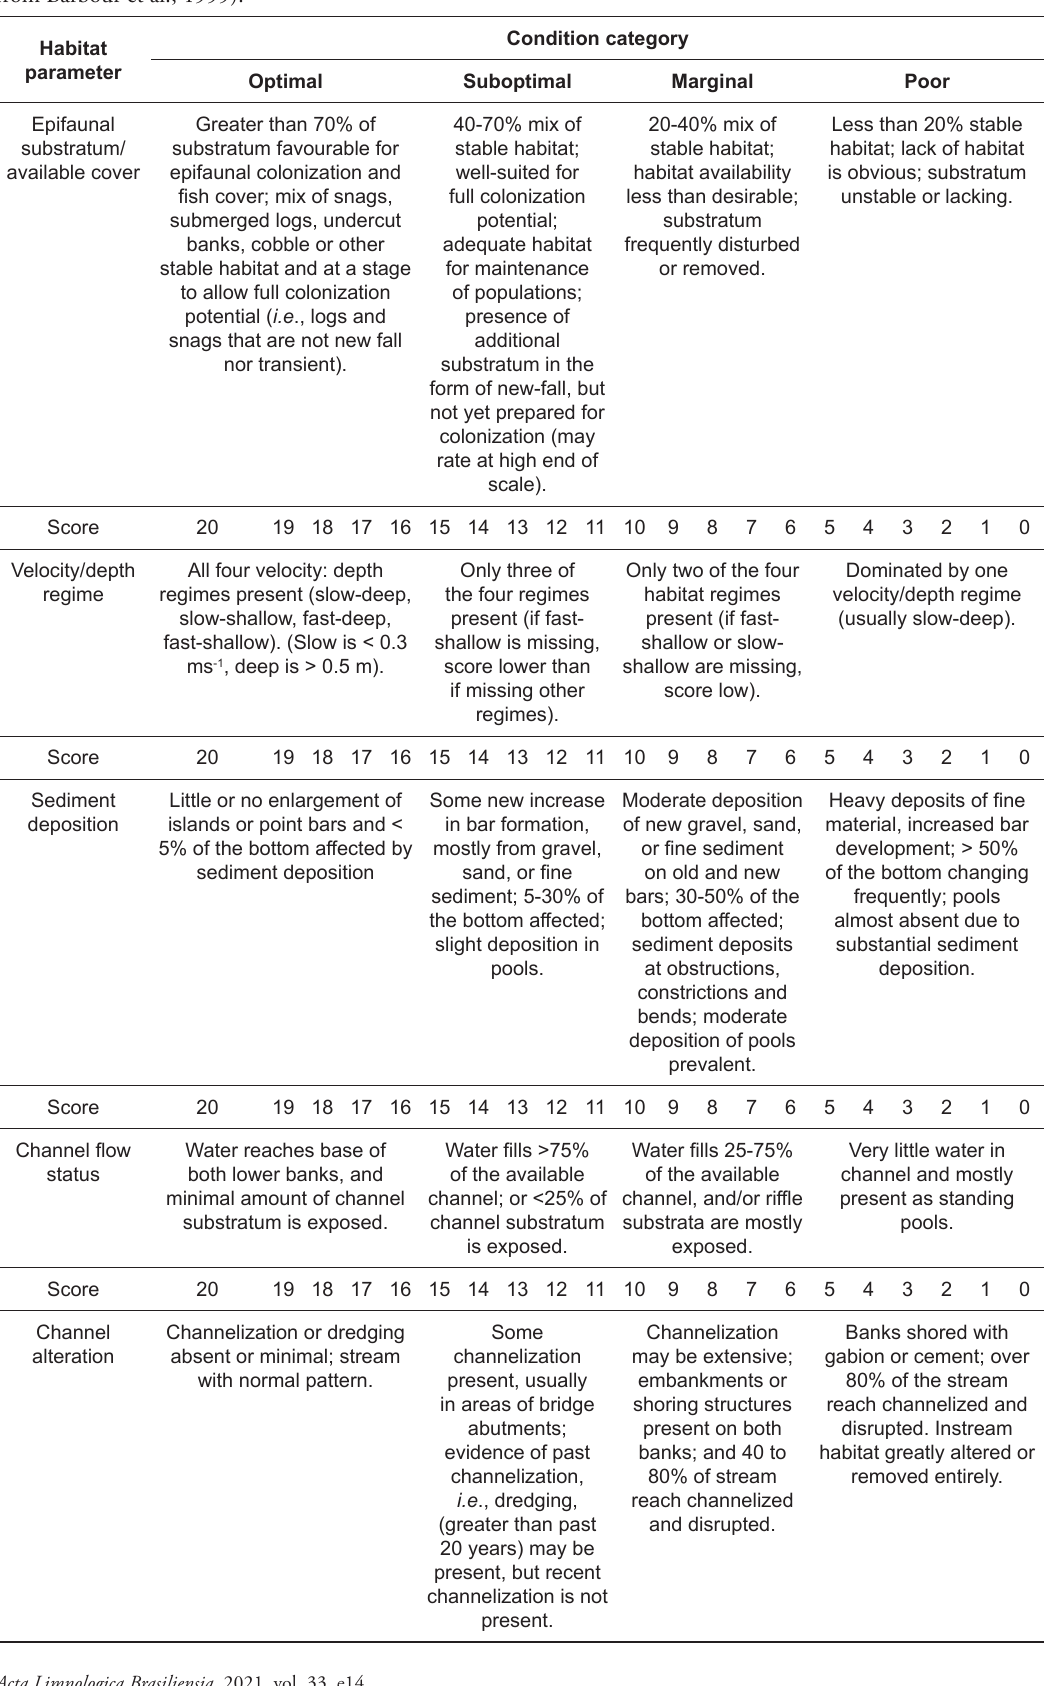
Table 1. Habitat parameters, condition categories and scores of the sampled streams from Sorocaba City (adapted from Barbour et al.,